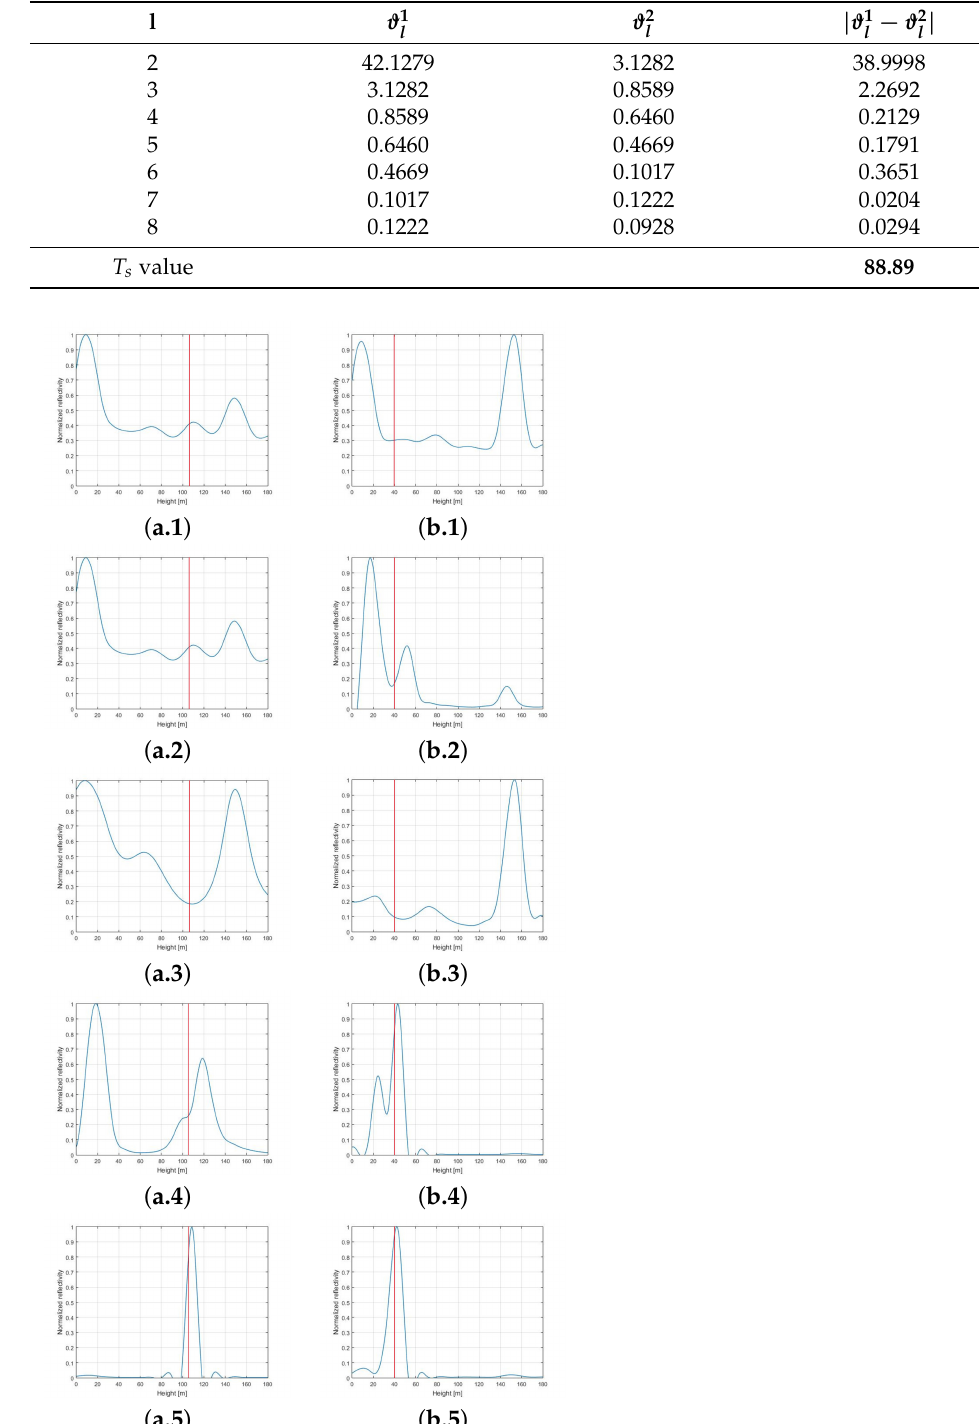
Figure 7. Reflectivity profiles for two azimuth–range pixels ( a , b ) using the ( 1 ) Standard MUSIC estimator, ( 2 ) BIC-MUSIC estimator, ( 3 ) Minimum-Norm estimator, ( 4 ) Regularized Minimum-Norm estimator, and ( 5 ) proposed regularized MUSIC